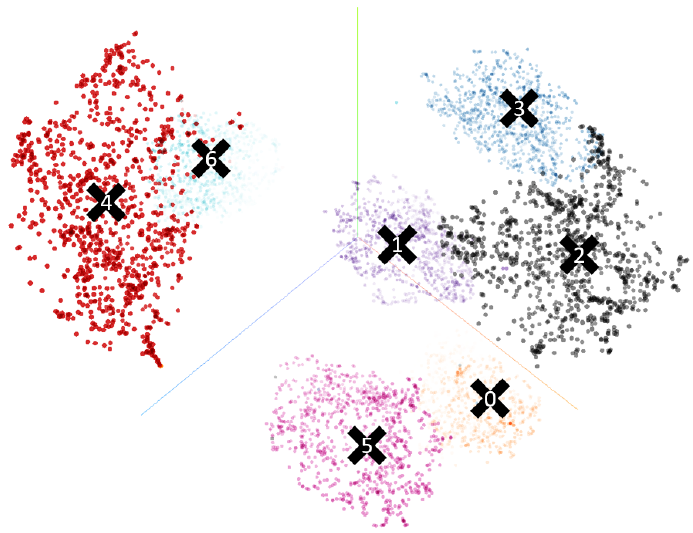
Figure 12. The embedding space is visually represented using 7k samples from the intersection model, using T-Distributed Stochastic Neighbor Embedding (t-SNE) function. Apart from the few outliers, the image depicts how the Teacher Network can separate the seven classes generated with our intersection model. In black, we conceptually represent the centroid of each of the